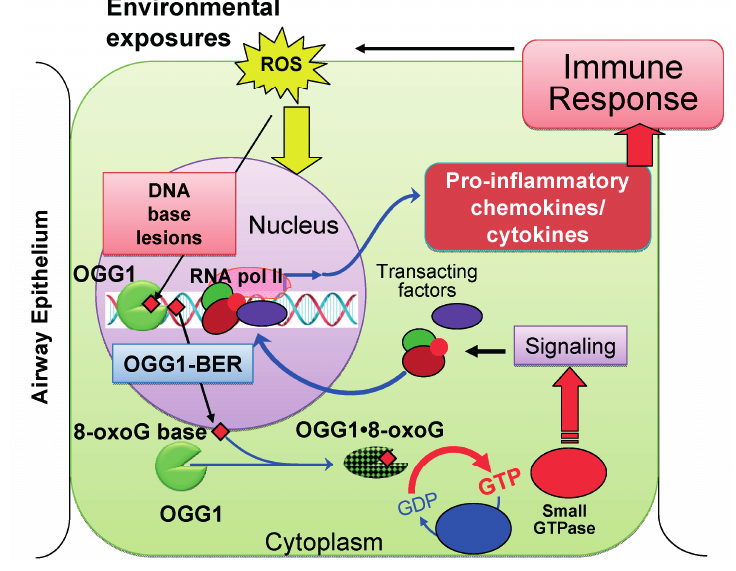
Figure 7. A proposed model for lung inflammation by repair of oxidatively damaged DNA via OGG1–BER. When environmental exposures occur or during an inflammatory process, Reactive oxygen species (ROS) are generated by cellular oxido-reductases and mitochondrial dysfunction in the airway epithelium. Due to guanine’s lowest oxidation potential, the most frequent base damage in DNA is 8-oxoG, which needs to be repaired to prevent mutations. 8-OxoG base is released by OGG1–BER (Figure 1) and transported to the cytoplasm, where it